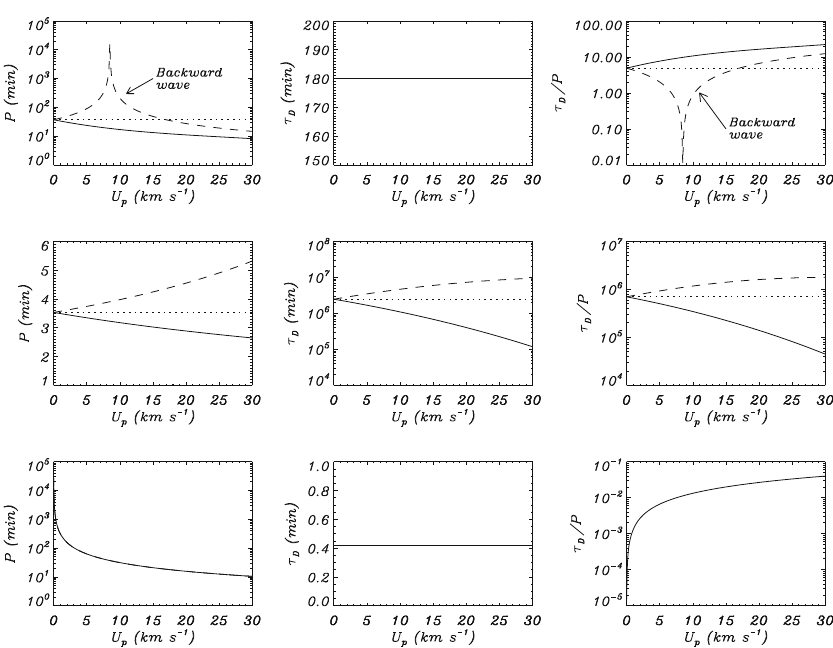
Fig. 63 Wave damping by thermal effects in a uniform, infinitely long thread (Fig. 44). Period (left), damping time (centre) and ratio of the damping time to the period (right) versus the flow velocity for the fundamental oscillatory modes. The upper, middle and lower panels correspond to the slow, fast kink and thermal modes, respectively. Different line styles represent parallel waves (solid line), anti-parallel waves (dashed line) and solutions in the absence of flow (dotted line). Image reproduced with permission from Soler et al. (2008), copyright by